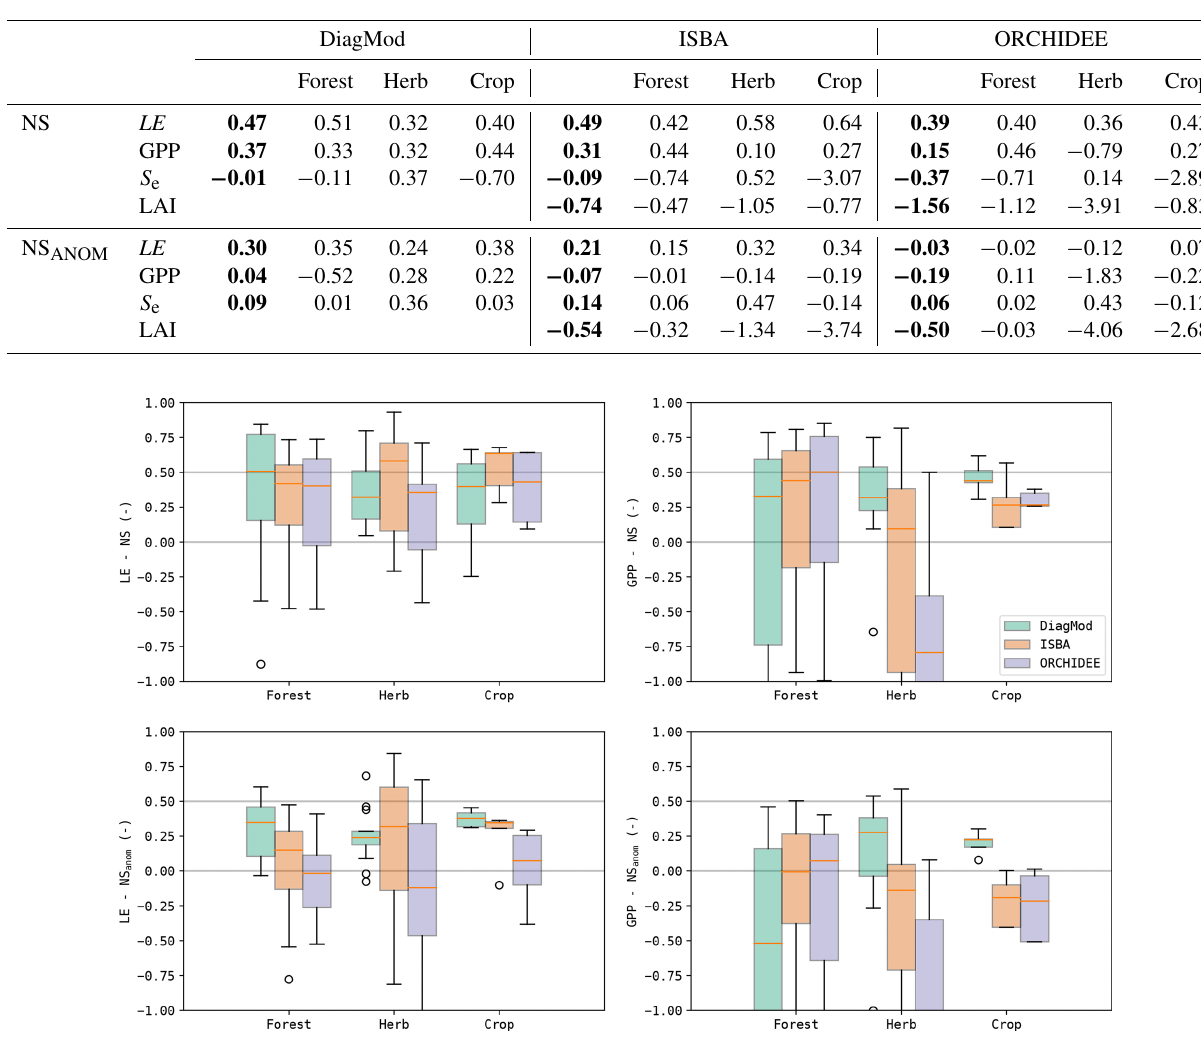
Figure 3. NS and NS ANOM of the simulated daily LE and GPP, grouped per land cover